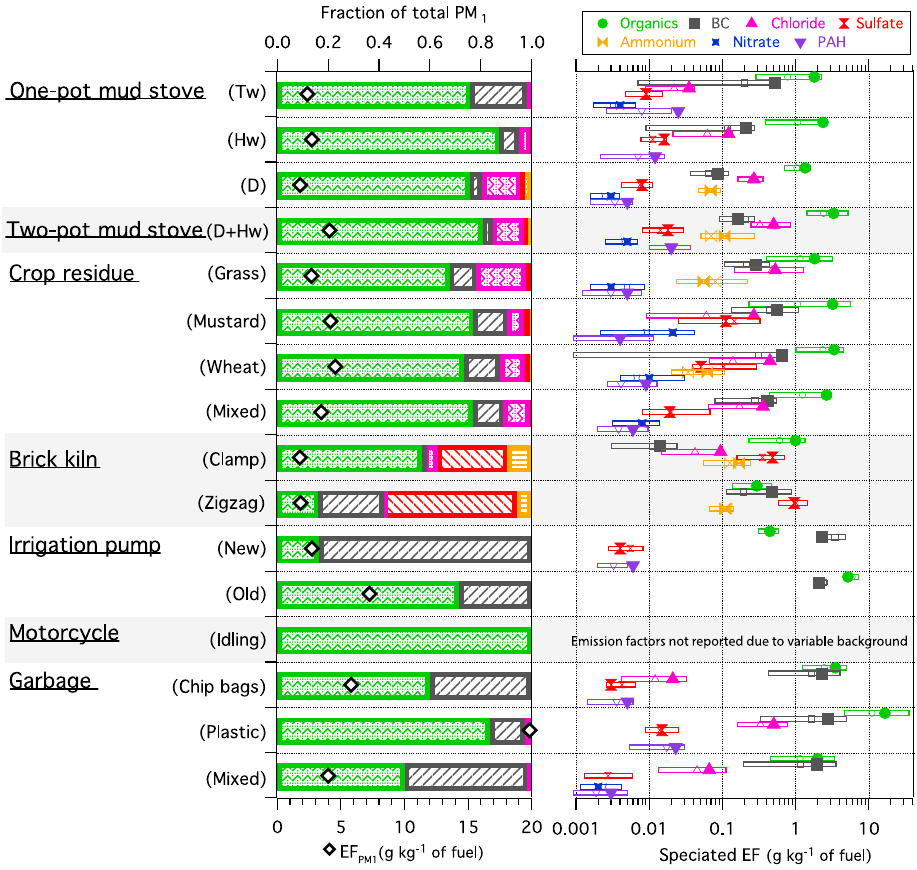
Figure 1. Summary of PM 1 fuel-based emission factors and compositional fractions for the investigated emission sources. The colors of the horizontal bar chart correspond with the species colors designated by markers in the speciated emission factor panel. In the right panel the closed markers represent the test-integrated average speciated emission factor, the open markers represent the median speciated emission factor, and the bars represent the 25th and 75th percentile speciated emission factors for the combined observations from each emission source. Mud stove fuel types are hardwood (Hw), dung (D), and sticks and twigs